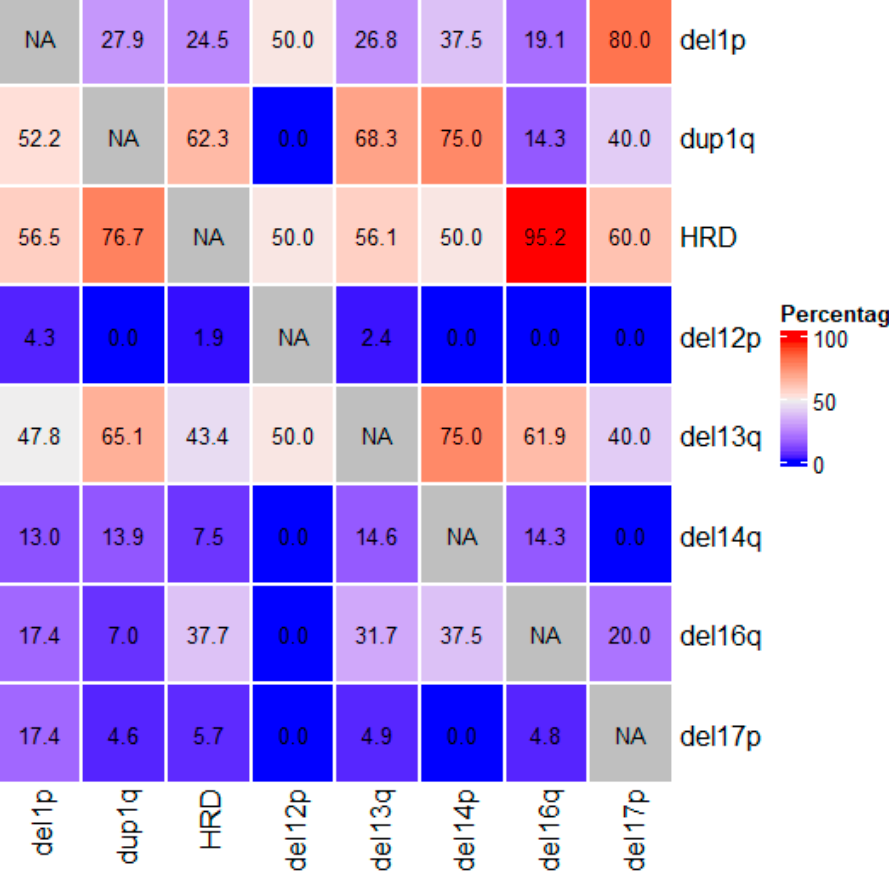
Figure A3. Heatmap of pairwise association between CNAs. The percentage was calculated from the positive group. Each row is a group.